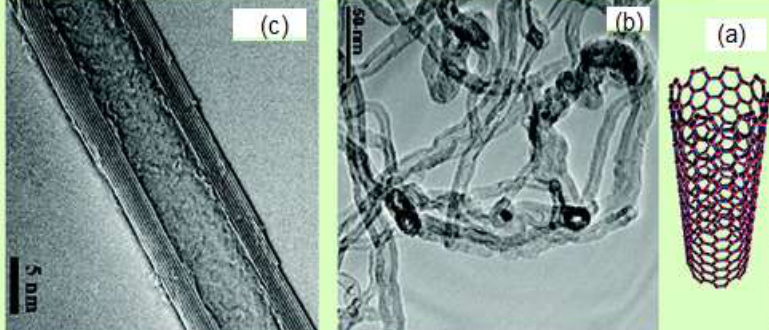
Fig.1: (a) TEM- image of the CNT structure, (b) “bundle” of CNTs in a raw form produced by (CVD) method and (c) TEM image of a MWNT up to ten walls can be counted